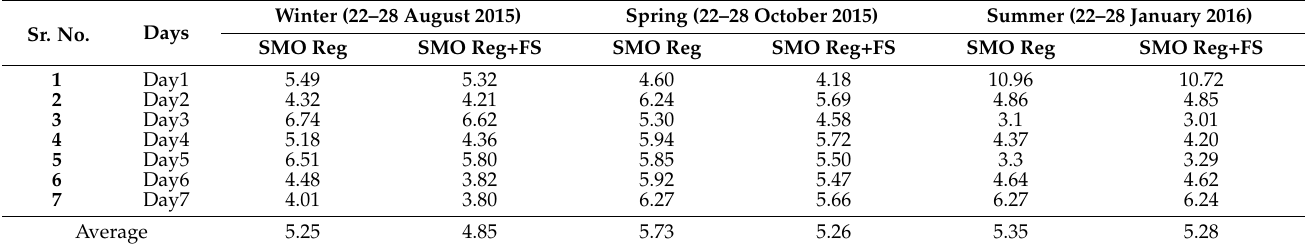
Table 6 summarizes the daily MAPE corresponding to SMO regression and SMO regression +FS. The daily errors for the winter, spring and summer seasons, using the SMO regression and SMO regression + FS are depicted in Figures 6–8. These results indicate that the performance of the SMO regression + FS is generally better than the performance of the SMO regression. Table 6. Comparative daily MAPE corresponding to SMO regression and SMO regression +FS. Sr.